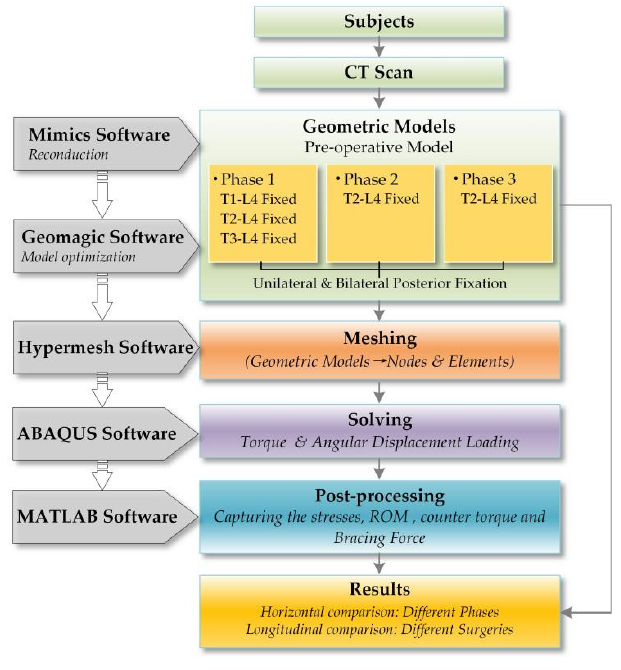
Figure 2. Flowchart of the entire study.